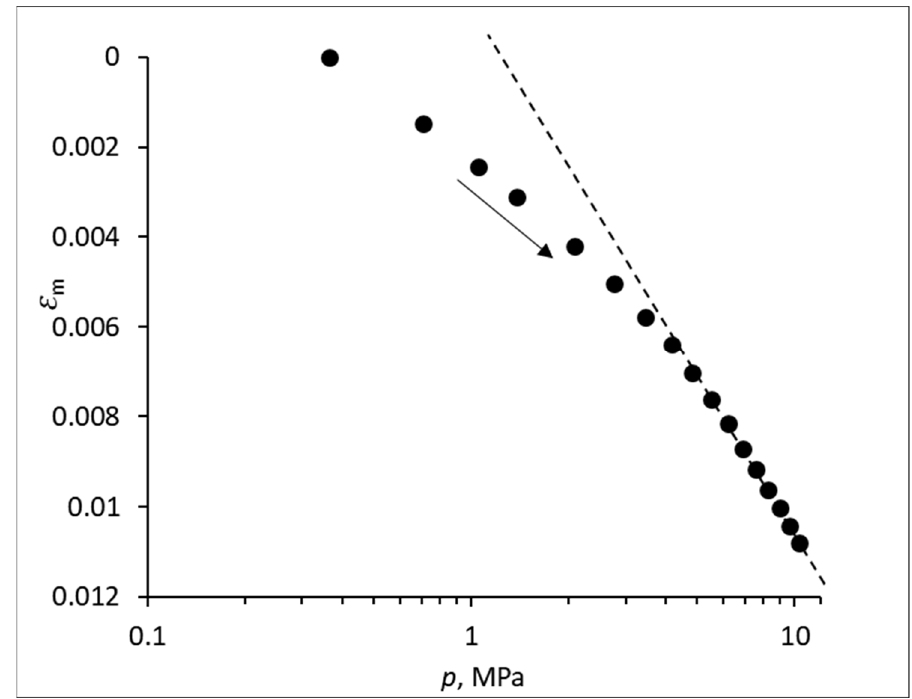
Figure 3. Strain–stress path of coal sample 2 under monotonic stress increase (up to 10.3 MPa or 1500 psi).